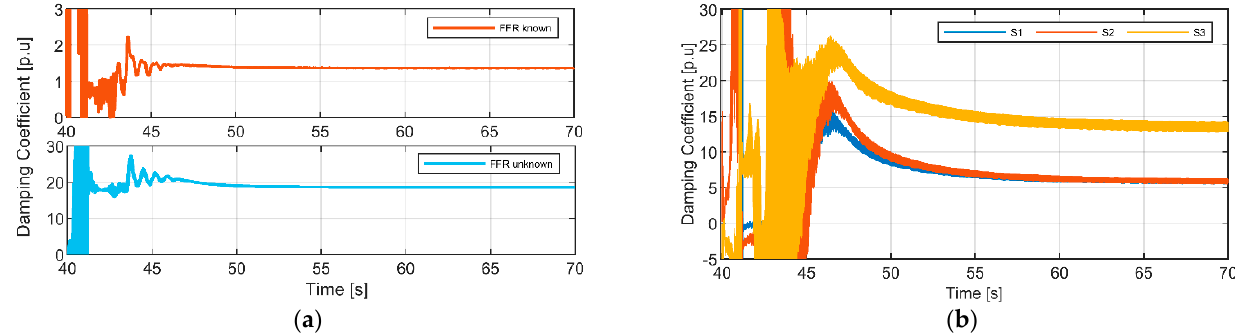
Figure 7 . The impact of parameterization on the damping coefficient estimation: ( a ) comparison of the effect of parameterization on the damping estimation in Area 2 of the 39-bus system; ( b ) comparison of the overall system damping under different scenarios.